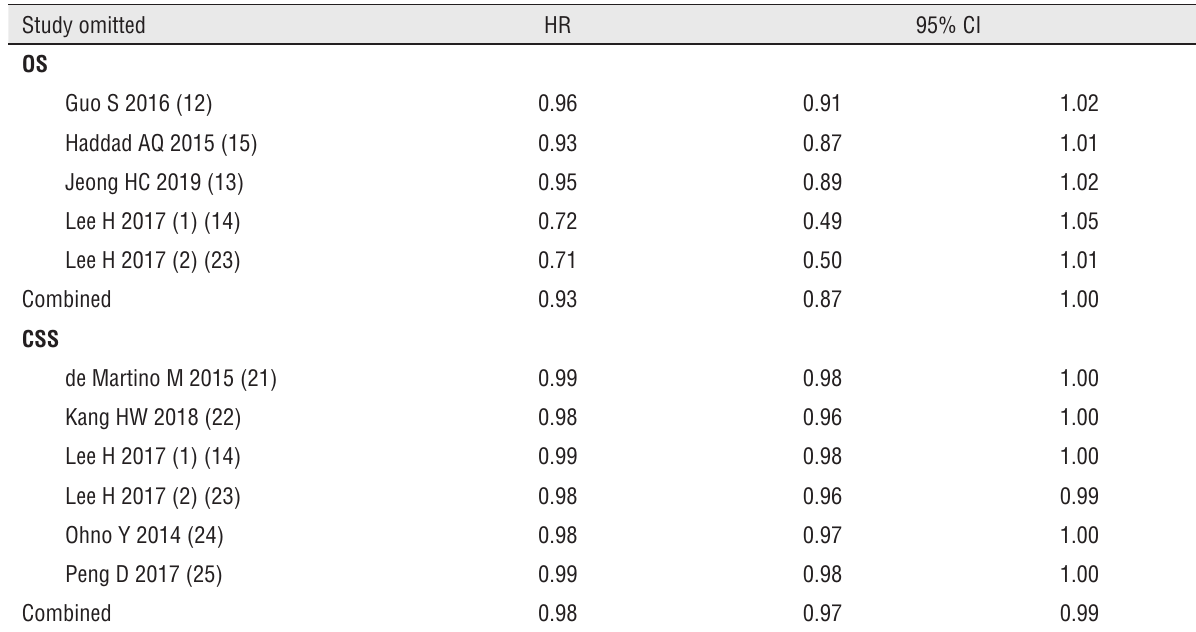
Table 3 - Results of sensitivity analyses.